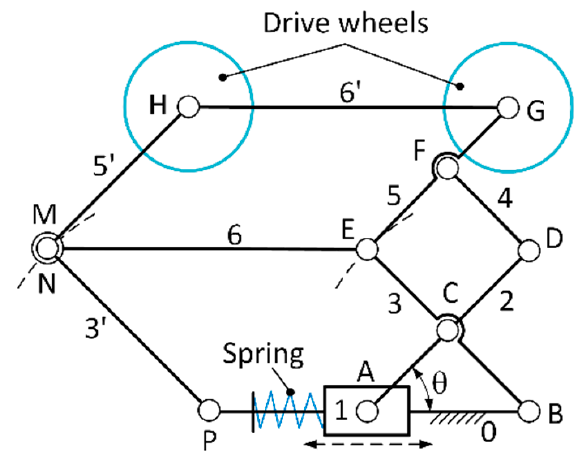
Figure 14. Adapting mechanism based on pantograph linkage with one slider.